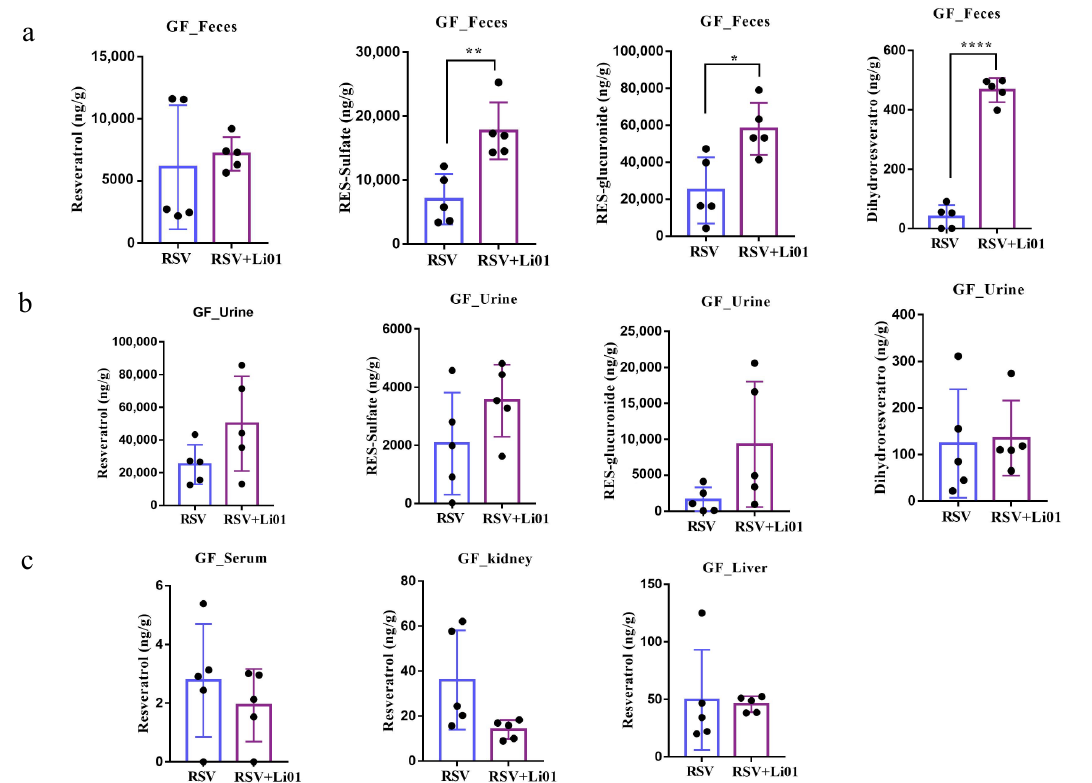
Figure 3. Quantification of RSV and its metabolites in feces ( a ), urine ( b ), serum, and tissues ( c ) in germ-free mice with/without Li01 colonization. Data are presented as mean ± SEM ( n = 5). Significant difference was represented by * p < 0.05, ** p < 0.01, **** p < 0.0001, and analyzed by either independent-samples t -test or nonparametric test (Mann–Whitney